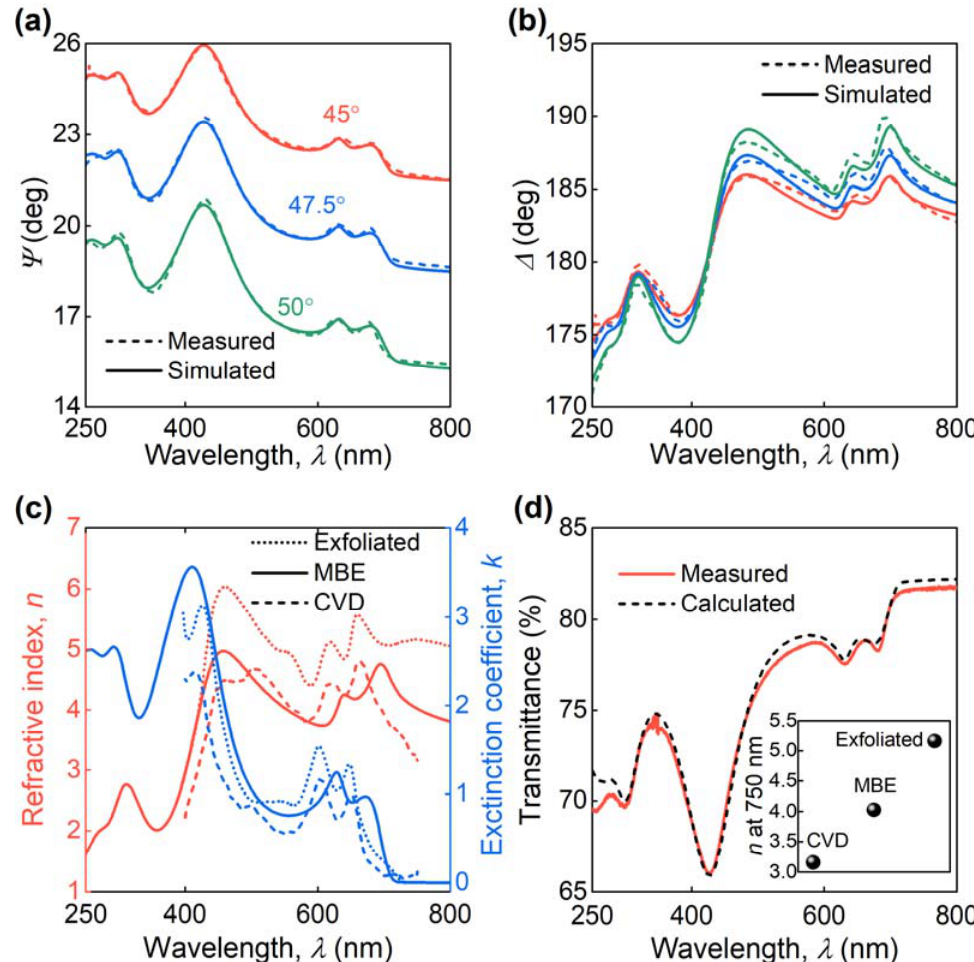
Figure 4. Optical properties of MBE MoS 2 . Plots of the measured and calculated MBE MoS 2 ellipsometric parameters ( a ) Ψ and ( b ) Δ . ( c ) Optical constants ( n and k ) of epitaxial monolayer MoS 2 grown on a sapphire substrate from SE analysis of panels ( a , b ). For the tabular data, see Table A1. For comparison, we added optical constants of CVD and exfoliated MoS 2 from ref. [37] and [38], respectively. ( d ) Measured (red line) and calculated (black line) transmittance spectra of MBE MoS 2 on sapphire matching perfectly within spectrophotometer accuracy (1%) except in the 250 − 270 nm range, where inaccuracy approaches 2% attributed to the low signal sensitivity of our ellipsometer in that interval. The inset is a refractive index of exfoliated, MBE, and CVD MoS 2 at 750 nm.